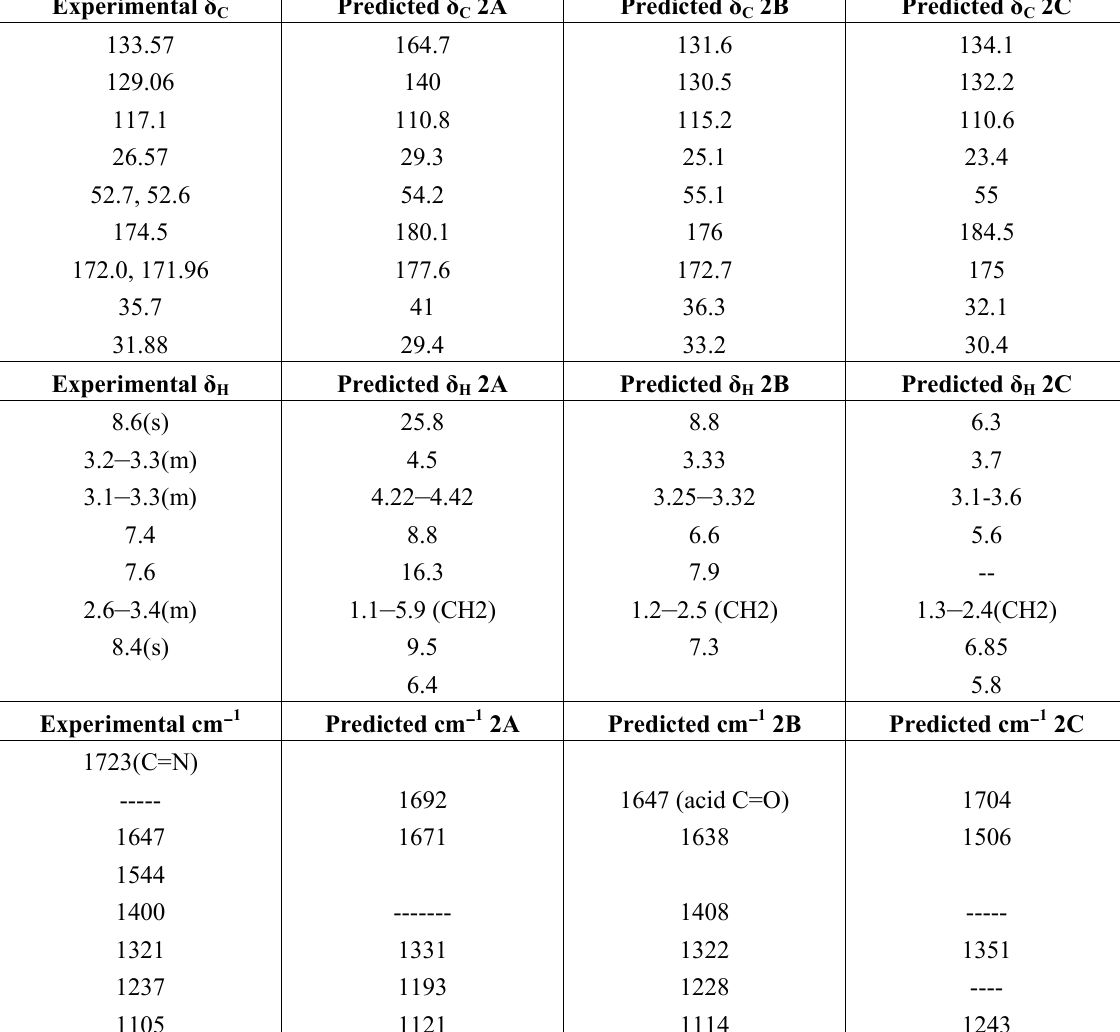
Table 5. Experimental and DFT predicted NMR and IR spectral